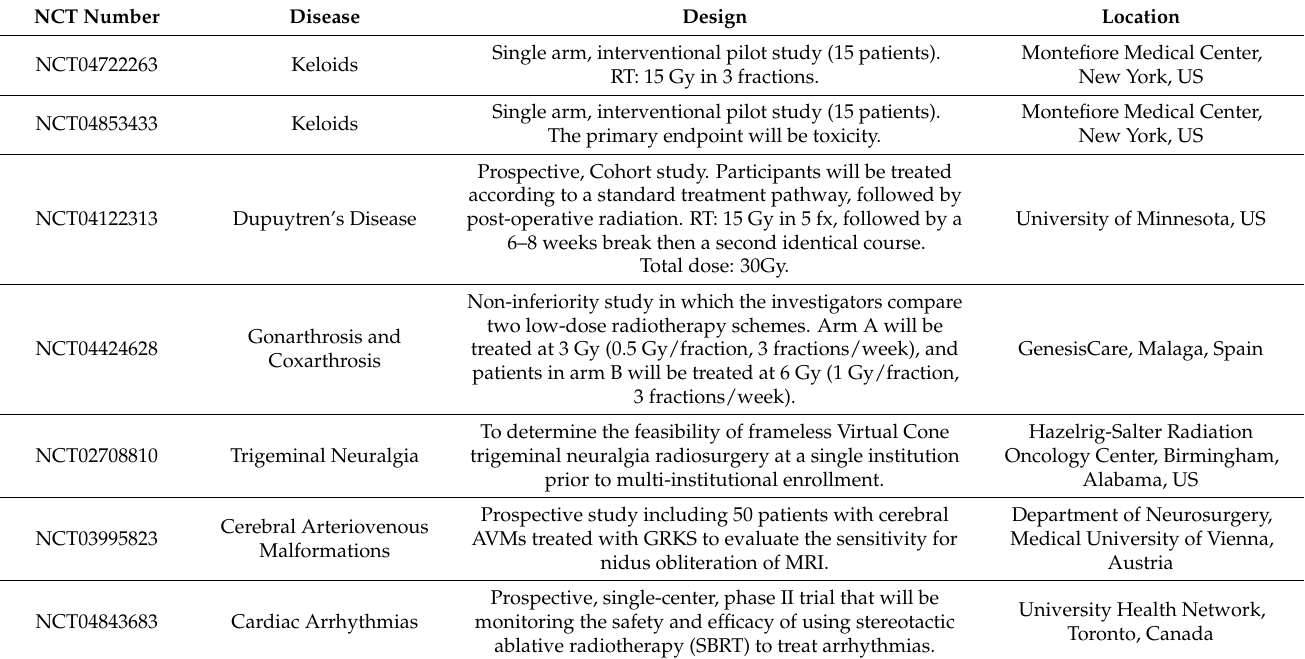
Table 5. Ongoing prospective clinical trial on non-oncological radiotherapy. Disease Design Single arm, interventional pilot study (15 patients). Keloids RT: 15 Gy in 3